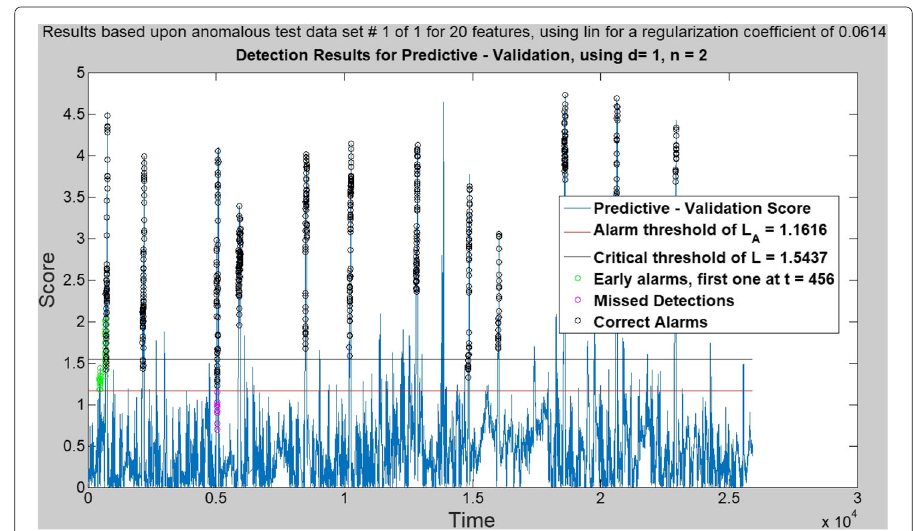
Fig. 6 ACCEPT graphical detection result plot with LIN and PV algorithm combination on fault case “ventilation fails”. As seen 12 larger spikes are present with black circles representing correct alarms. The gradual evolution of each spike is hard to observe here, but is clarified in Fig. 7 for the first spike